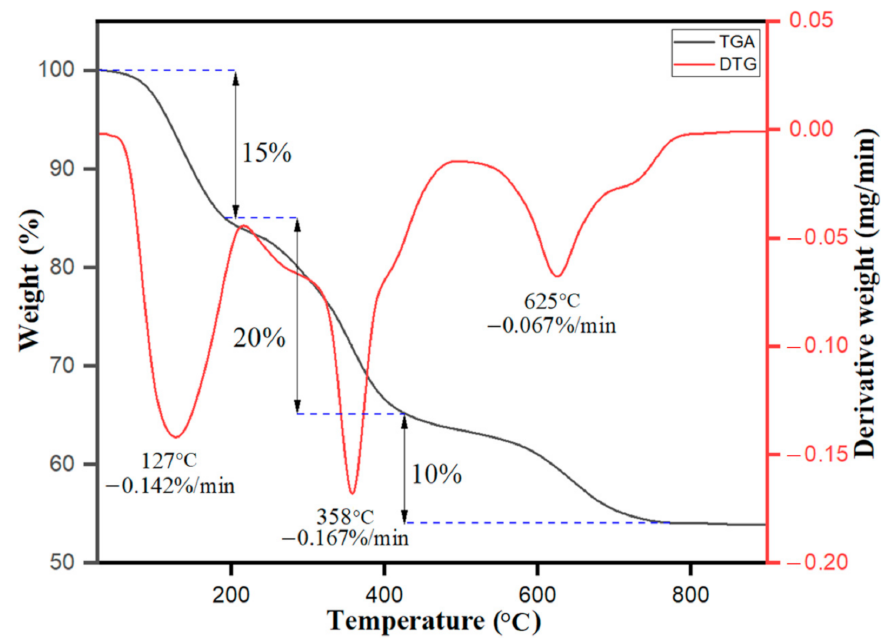
Figure 4. TGA-DTG curves for Ag-Fe